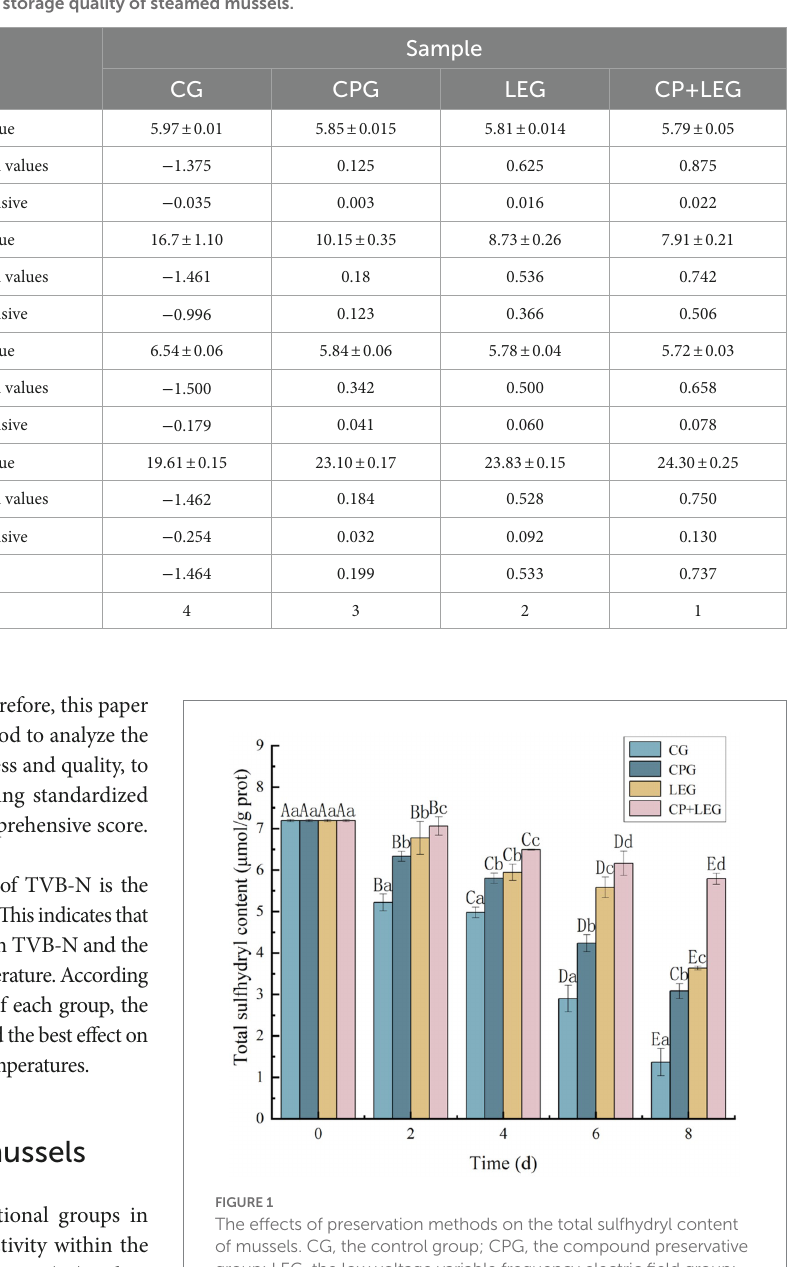
TABLE 3 Comprehensive scores of the ice-temperature storage quality of steamed mussels.